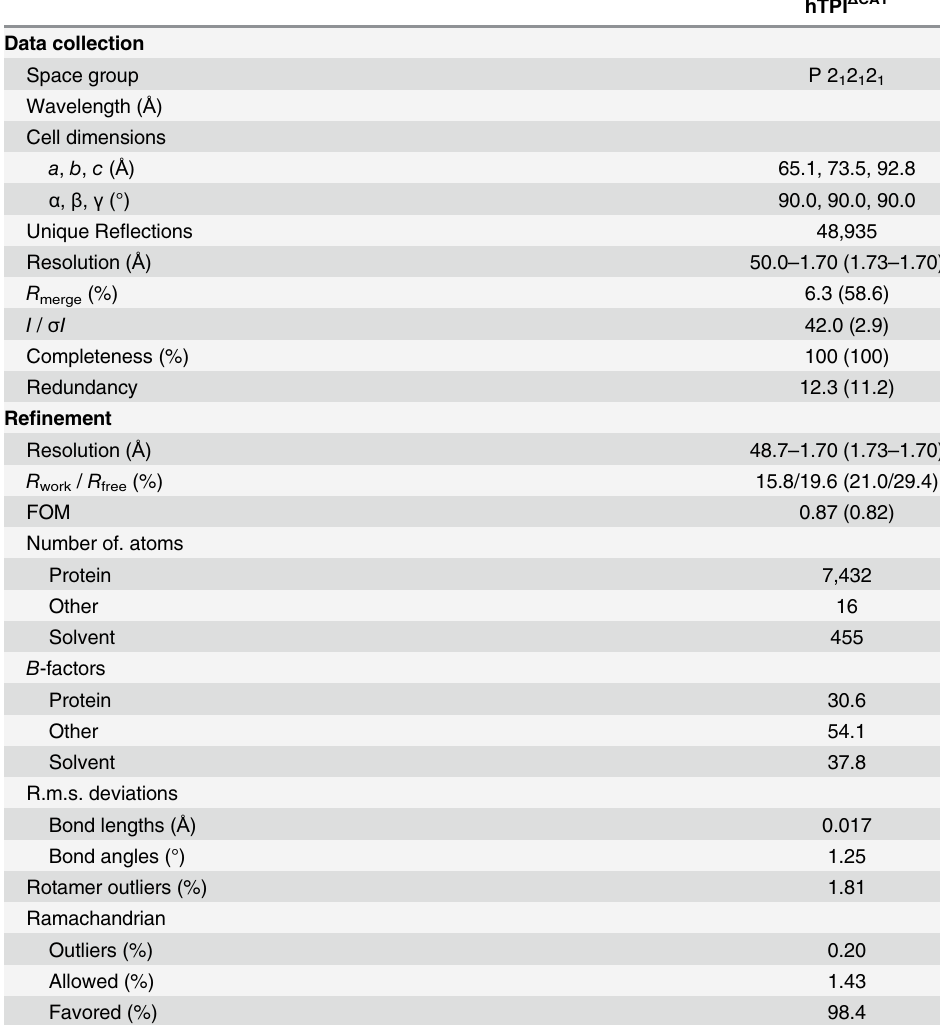
Table 1. Crystallographic Data collection and Refinement